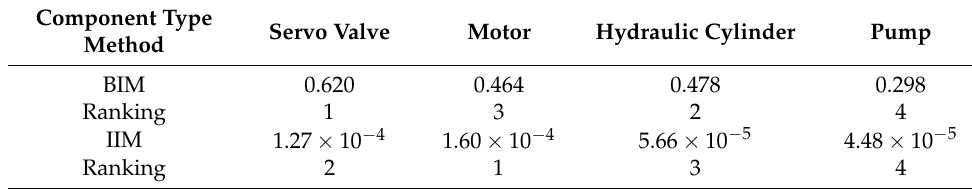
Table 2. BIM and IIM comparison at 4500 h.